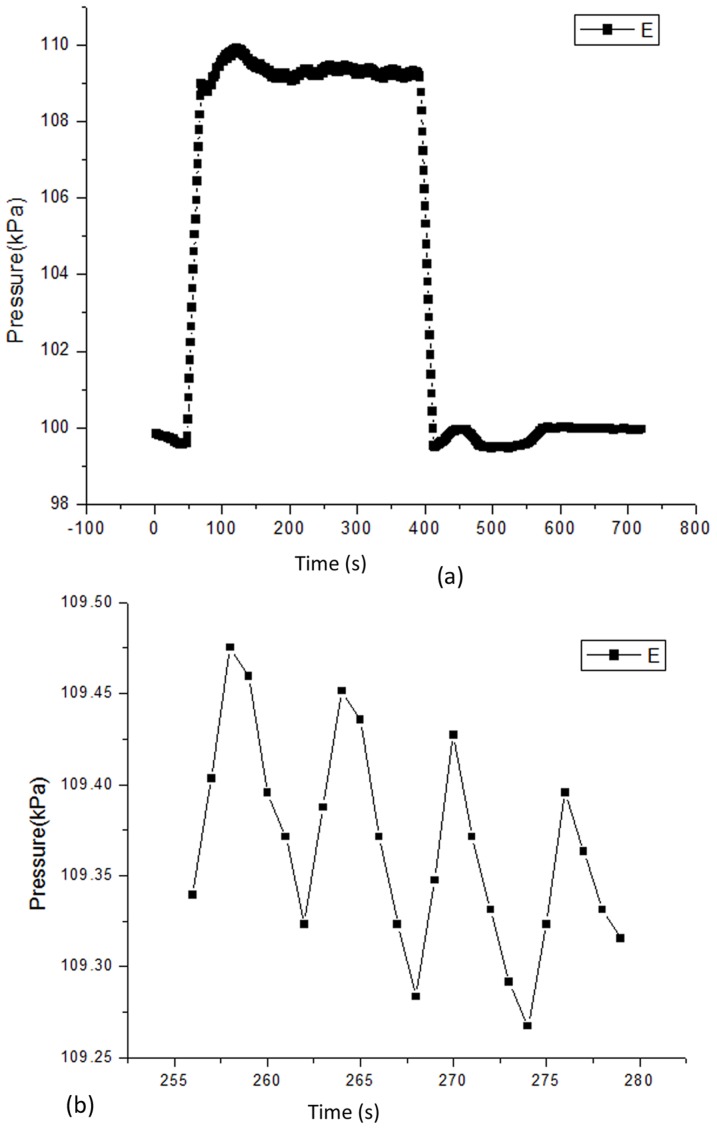
The blood pressure data obtained from the experiment.(a) Units of optical fiber pressure sensor: the vertical axis represents pressure with units of kPa and the horizontal axis represents time with units of s. (b) An expanded view of a section of the high pressure curve.